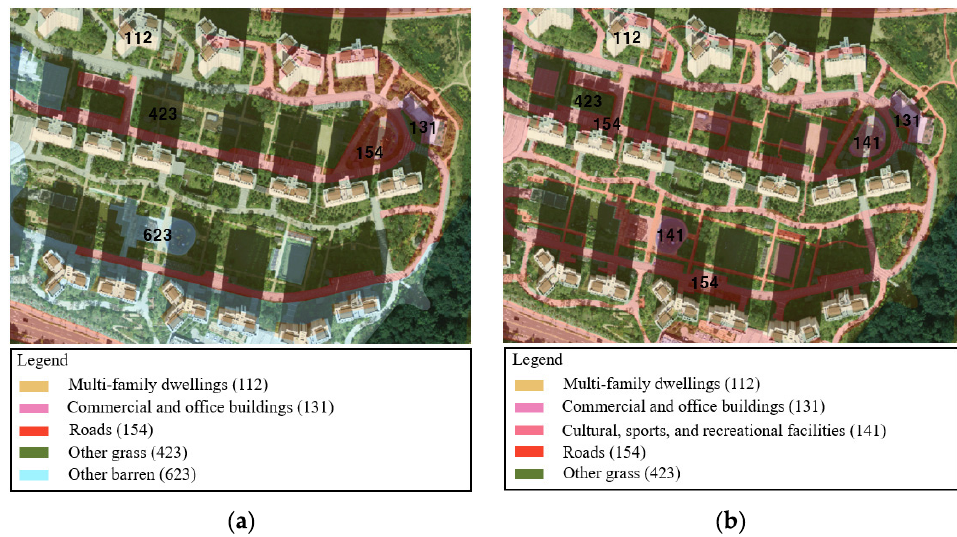
Figure 3. Example results of the first detailed landcover map update process, ( a ) Existing landcover map; ( b ) Landcover map after the first update.